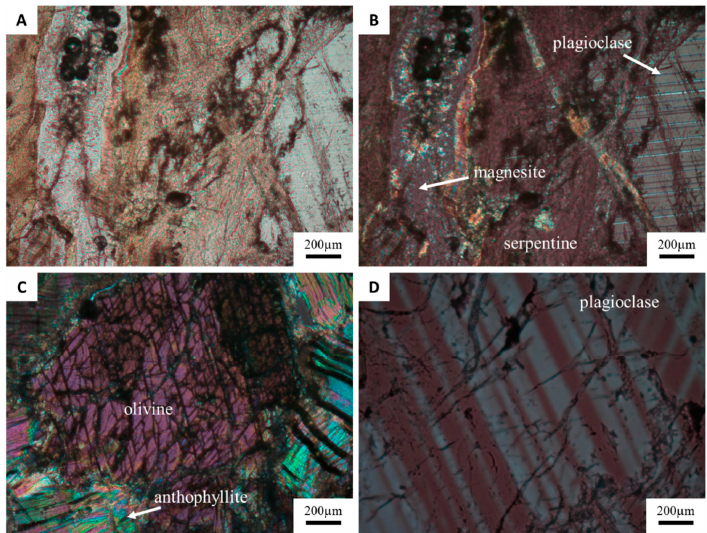
Figure 7. Optical microscopy (plane polarized light; ( A ); crossed polars; ( B , C , D )) images of a clayey serpentinite with abundant plagioclase (sample W3); ( A , B ) magnesite vein cutting the serpentine matrix; ( C ) fractured olivine relic in contact with anthophyllite; and ( D ) pagioclase with twinning.